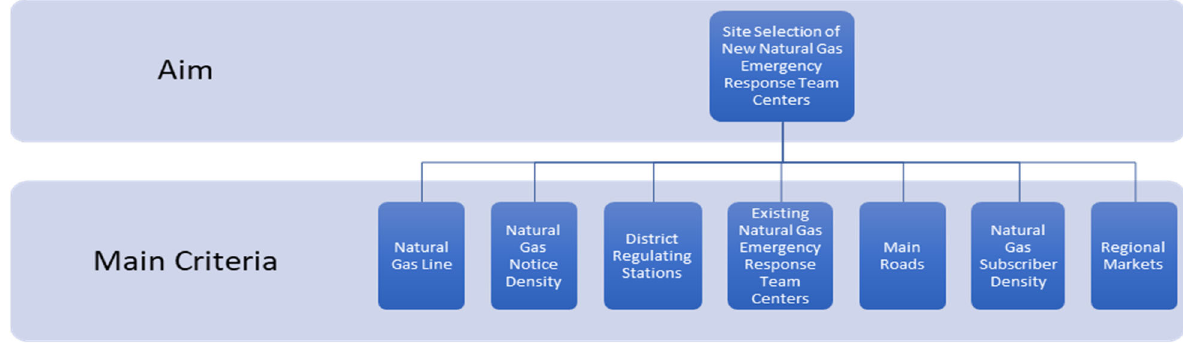
Figure 9. Hierarchical structure of FAHP. Table 6. Pairwise comparison matrix and weight values of criteria for natural gas emergency response team centers.